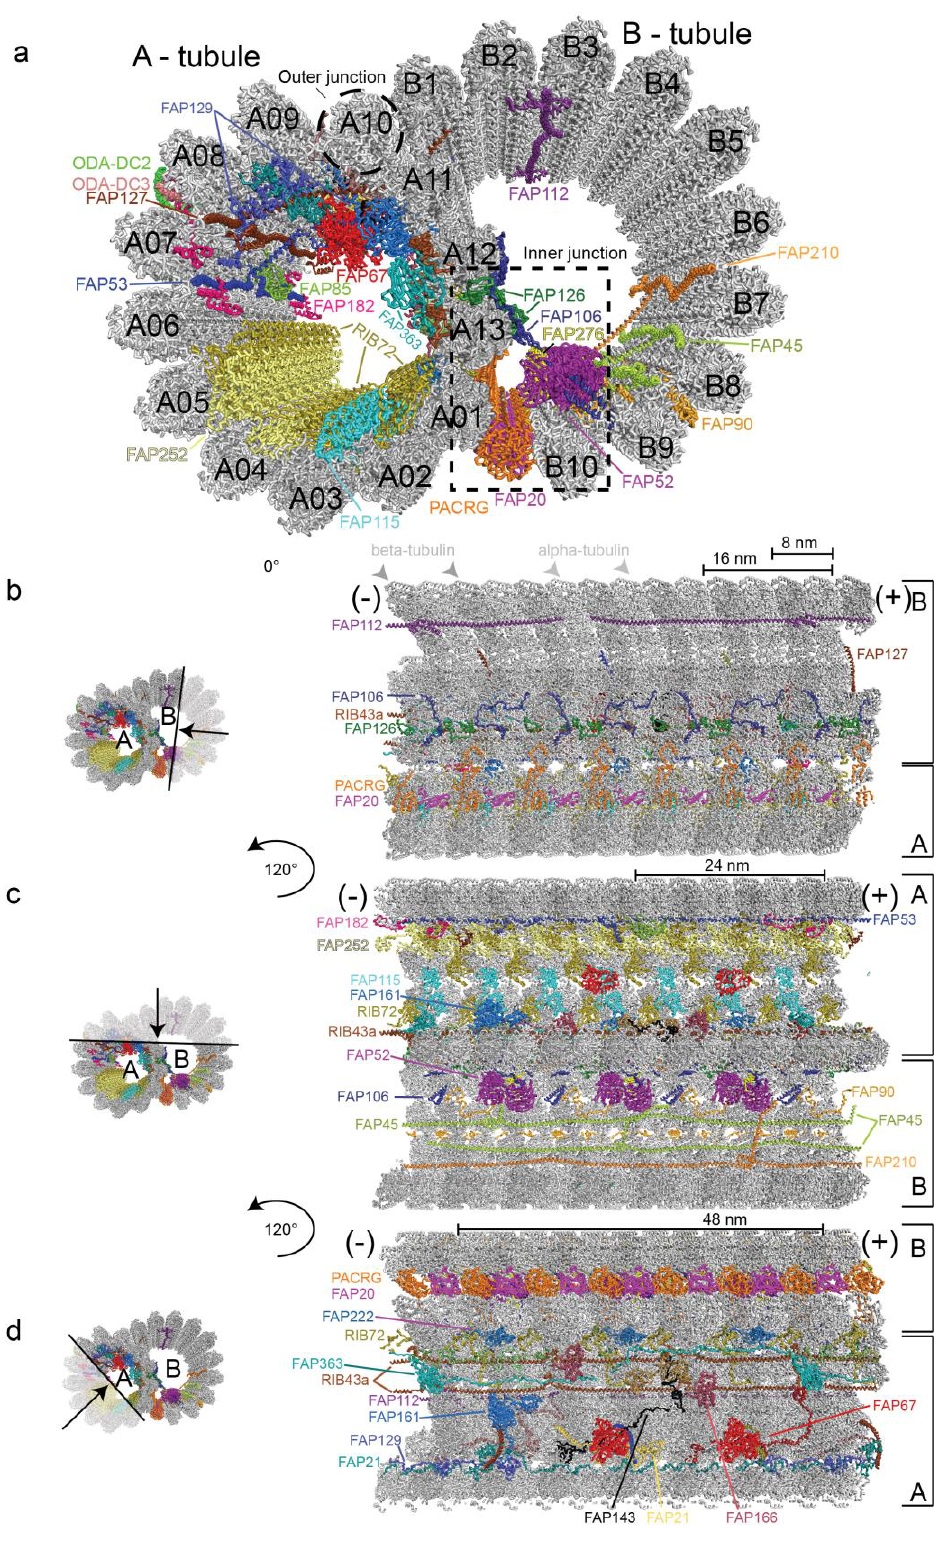
FIGURE 2: Structure of the 48nm ciliary doublet micro- tubule repeat (pdb entry: 6u42). (a) Cross